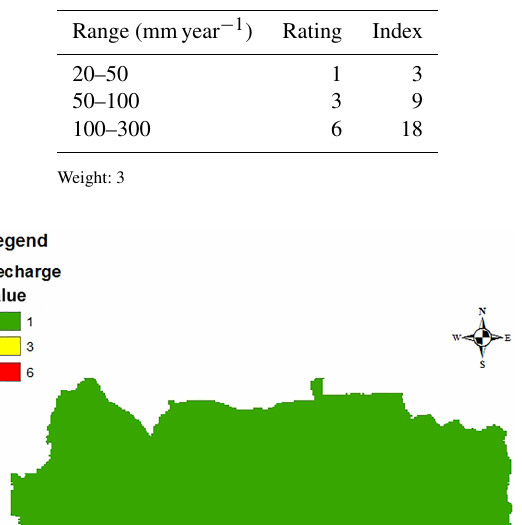
Table 2. Range and rating for net recharge.